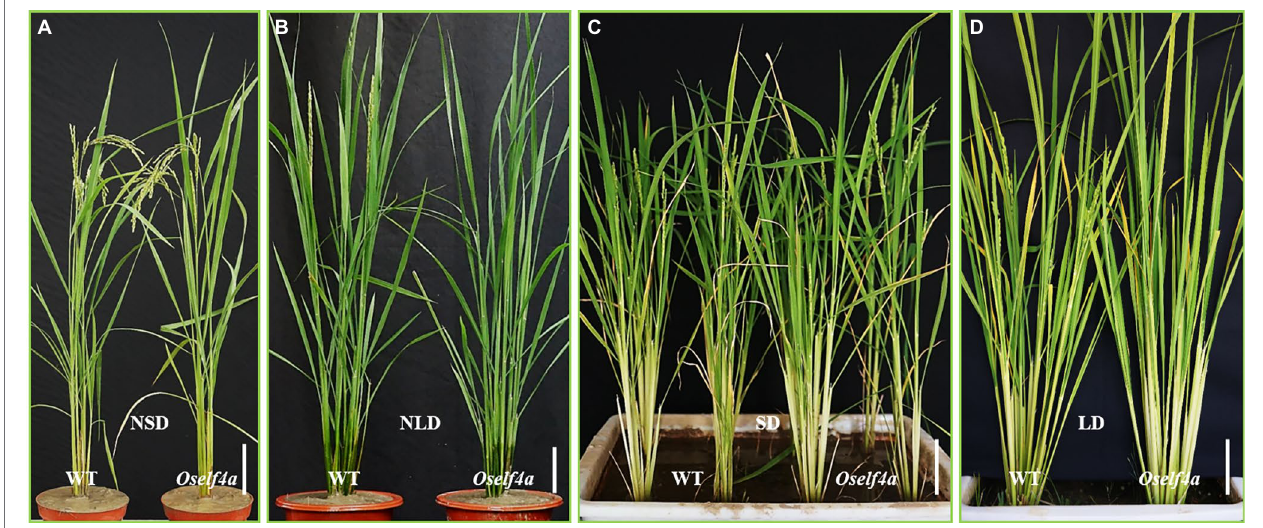
FIGURE 7 | Oself4a and WT plants grown under different day-length conditions. (A,B) in the field; (C,D) in the growth chamber. Scale bar = 10